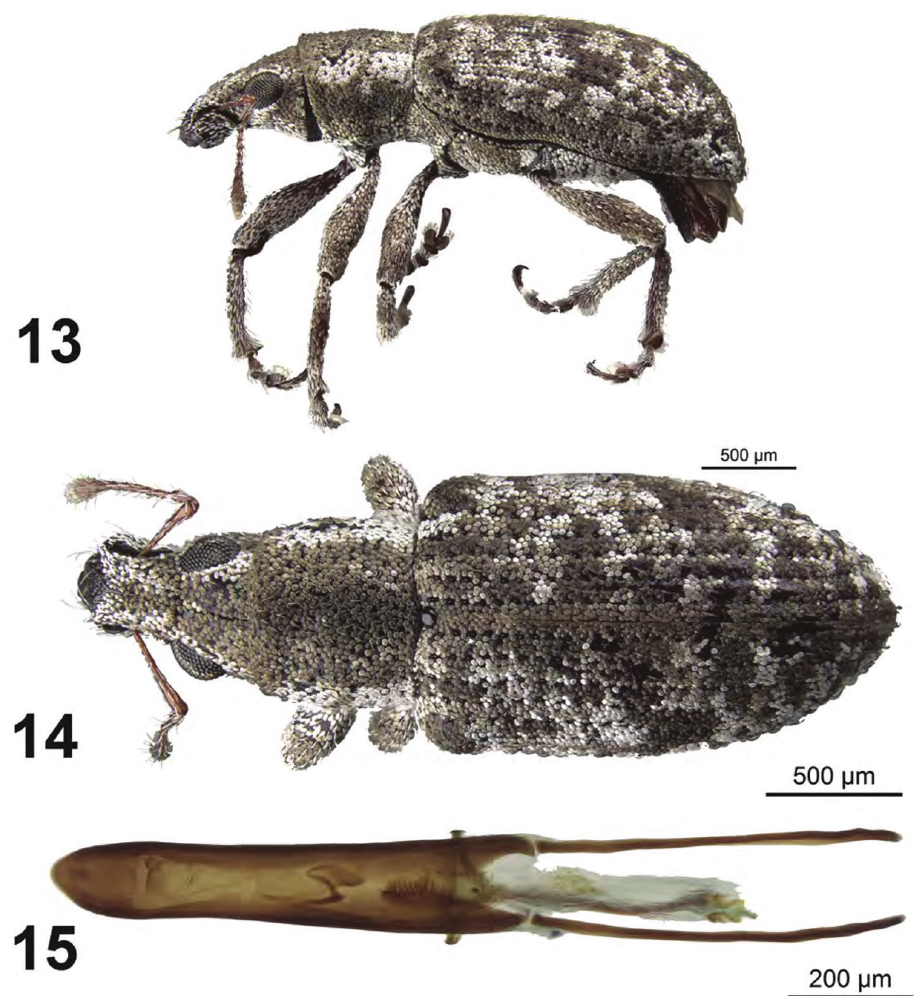
Figures 13–15. Apodrosus griseus. 13 Lateral habitus, male 14 Dorsal habitus, male 15 Male aedeagus,